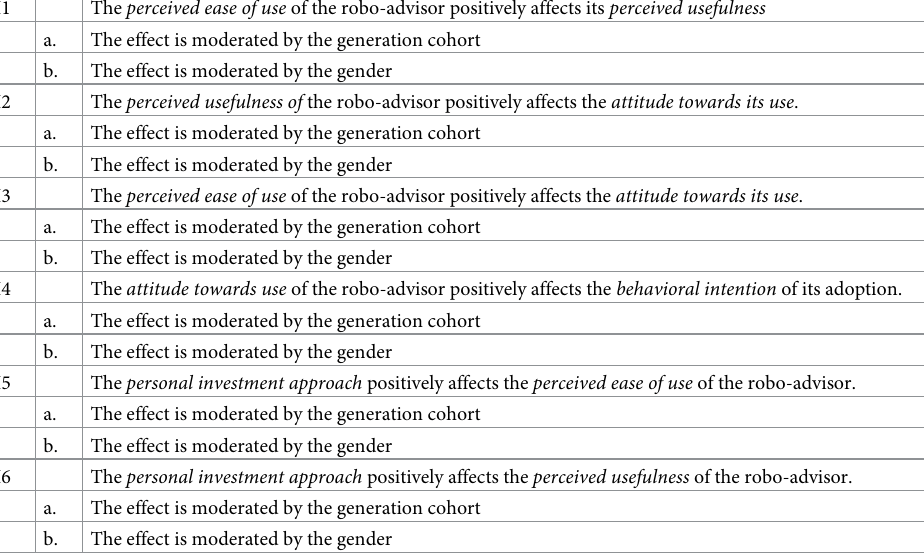
Table 1. Hypotheses under